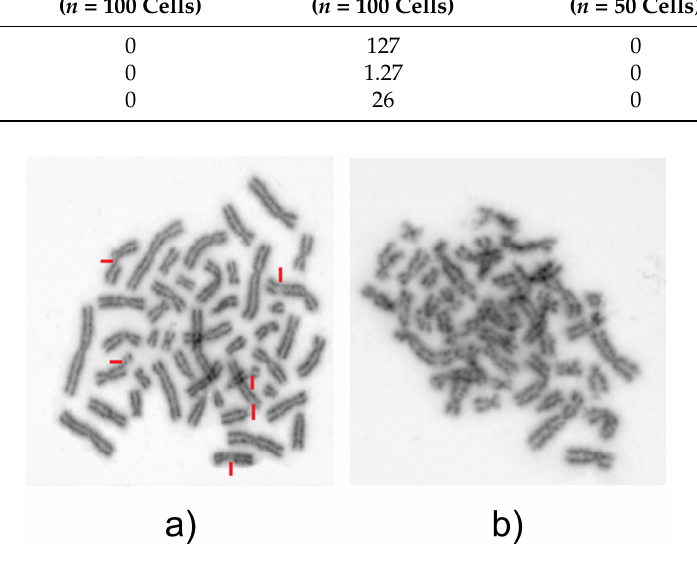
Figure 3. Bleomycin test: ( a ) 6 breaks/cell; ( b ) >50